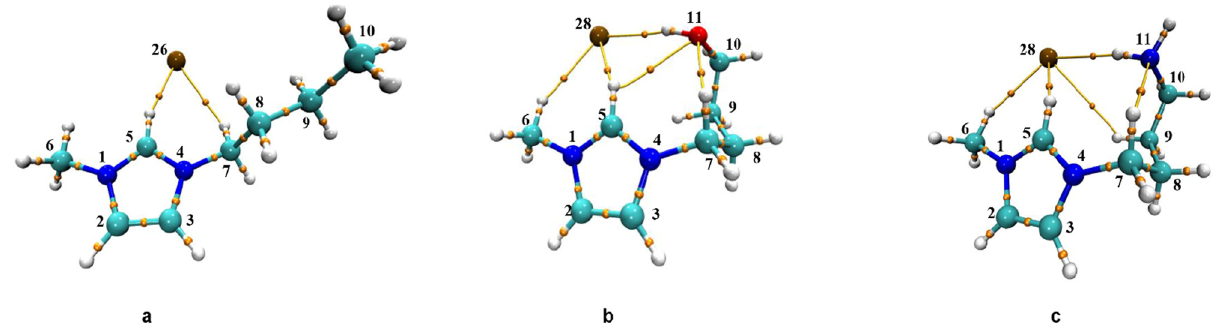
Figure 2: Topological graphs of ( a ) C 4 mimBr, ( b ) C 4 NH 2 mimBr, and ( c ) C 4 OHmimBr. H atoms are in white, C atoms are in cyan, N atoms are in blue, O atoms are in red, and Br atoms are in